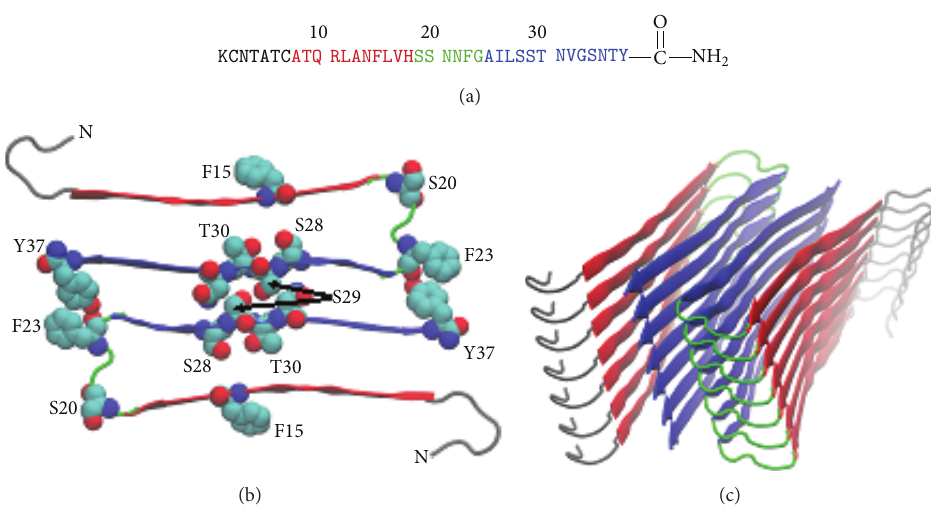
Figure 3: A model of the hIAPP fibril based on crystal structures of small peptide fragments of hIAPP. (a) Primary sequence of human IAPP. Residues color-coded red are found in the first 𝛽 -strand in the fibril; those colored blue in the second 𝛽 -strand and the ones located in the partially ordered loop that connects the two stands are colored green. The first seven residues are believed to be outside of the structured core of the fibril and are color-coded black. (b) Top down view of the model with several key residues shown. The N-termini are labeled. (c) View rotated by 90 ∘ showing the arrangement of the two stacks as a ribbon